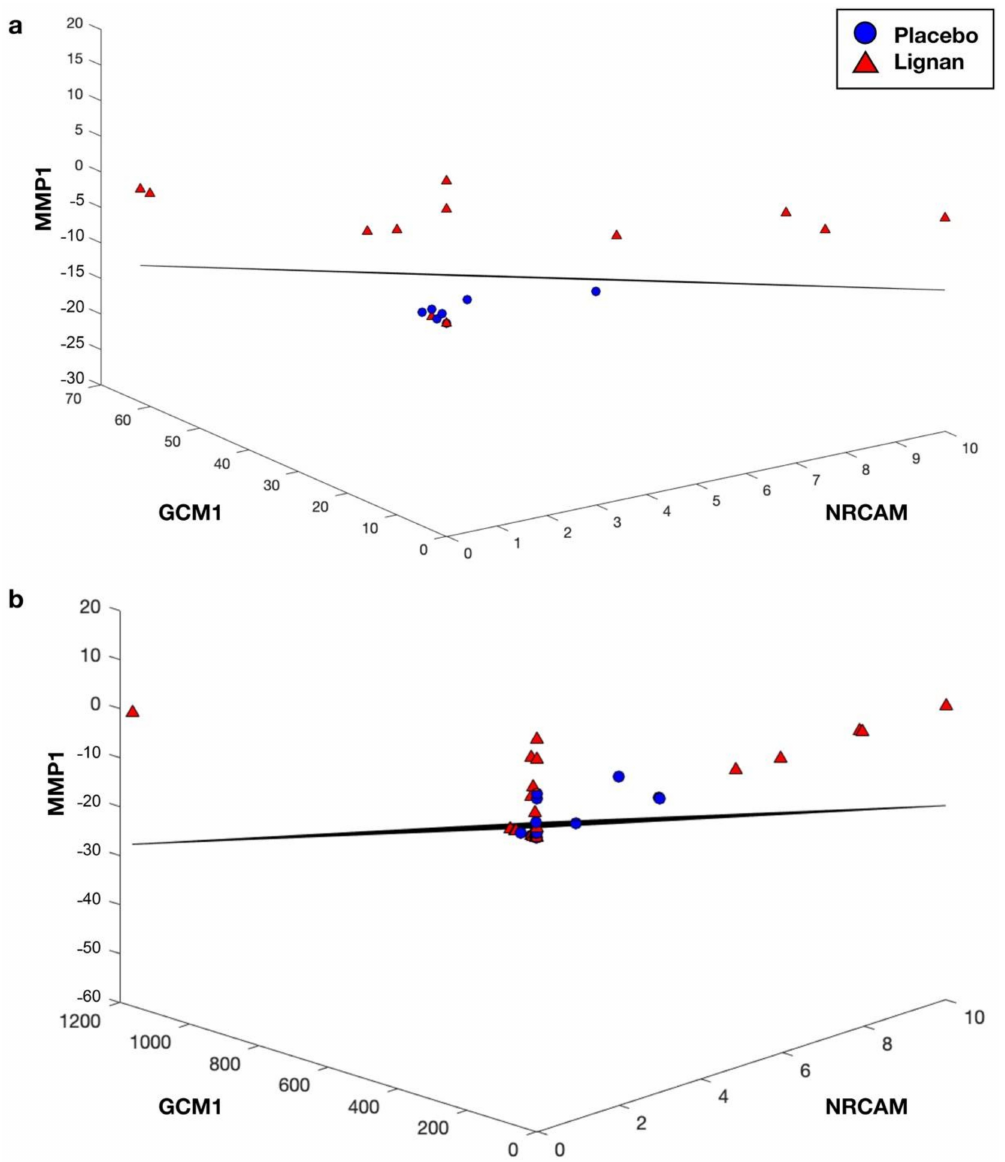
Figure 2. The top performing high-ENL phenotype three-gene classifier based on MMP1, GCM1 and NRCAM expression: ( a ) high-ENL participants only (13 placebo, 14 lignan); ( b ) all participants (25 placebo, 29